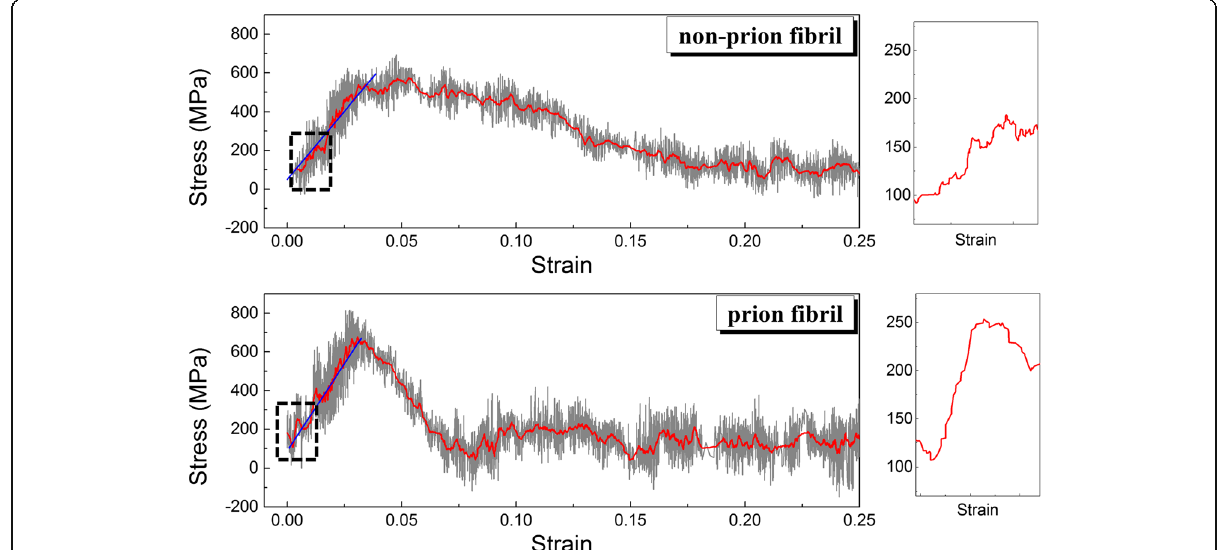
Fig. 2 Stress-strain curves for non-prion and prion fibrils, when these fibrils are pulled along the fibril axis. The black dashed region of the stress-strain curve is shown in the right